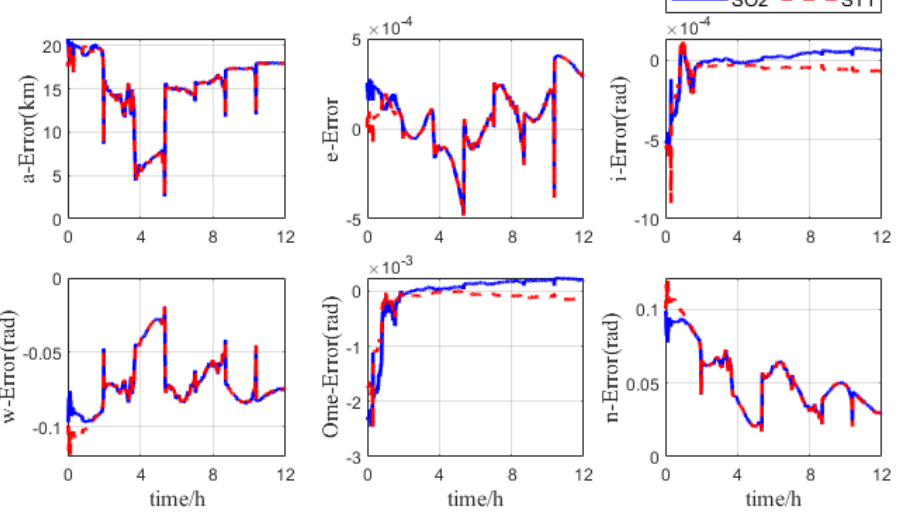
Figure 4. Estimation errors of orbit elements in the symmetric case.